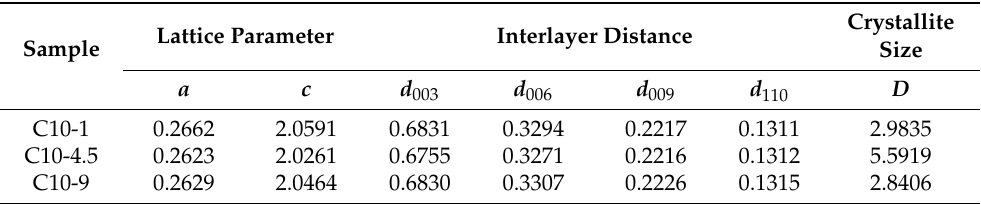
Table 1. XRD analysis results: cell parameters a and c and crystallite size D. All values are expressed in nm. Lattice Parameter Sample